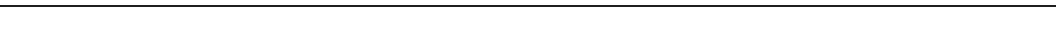
Fig. 2 Identi fi cation of exon 2 of LINC-PINT as a circRNA. a Upper, visualization of the forward reads within the exon 2 region in the LINC-PINT junction